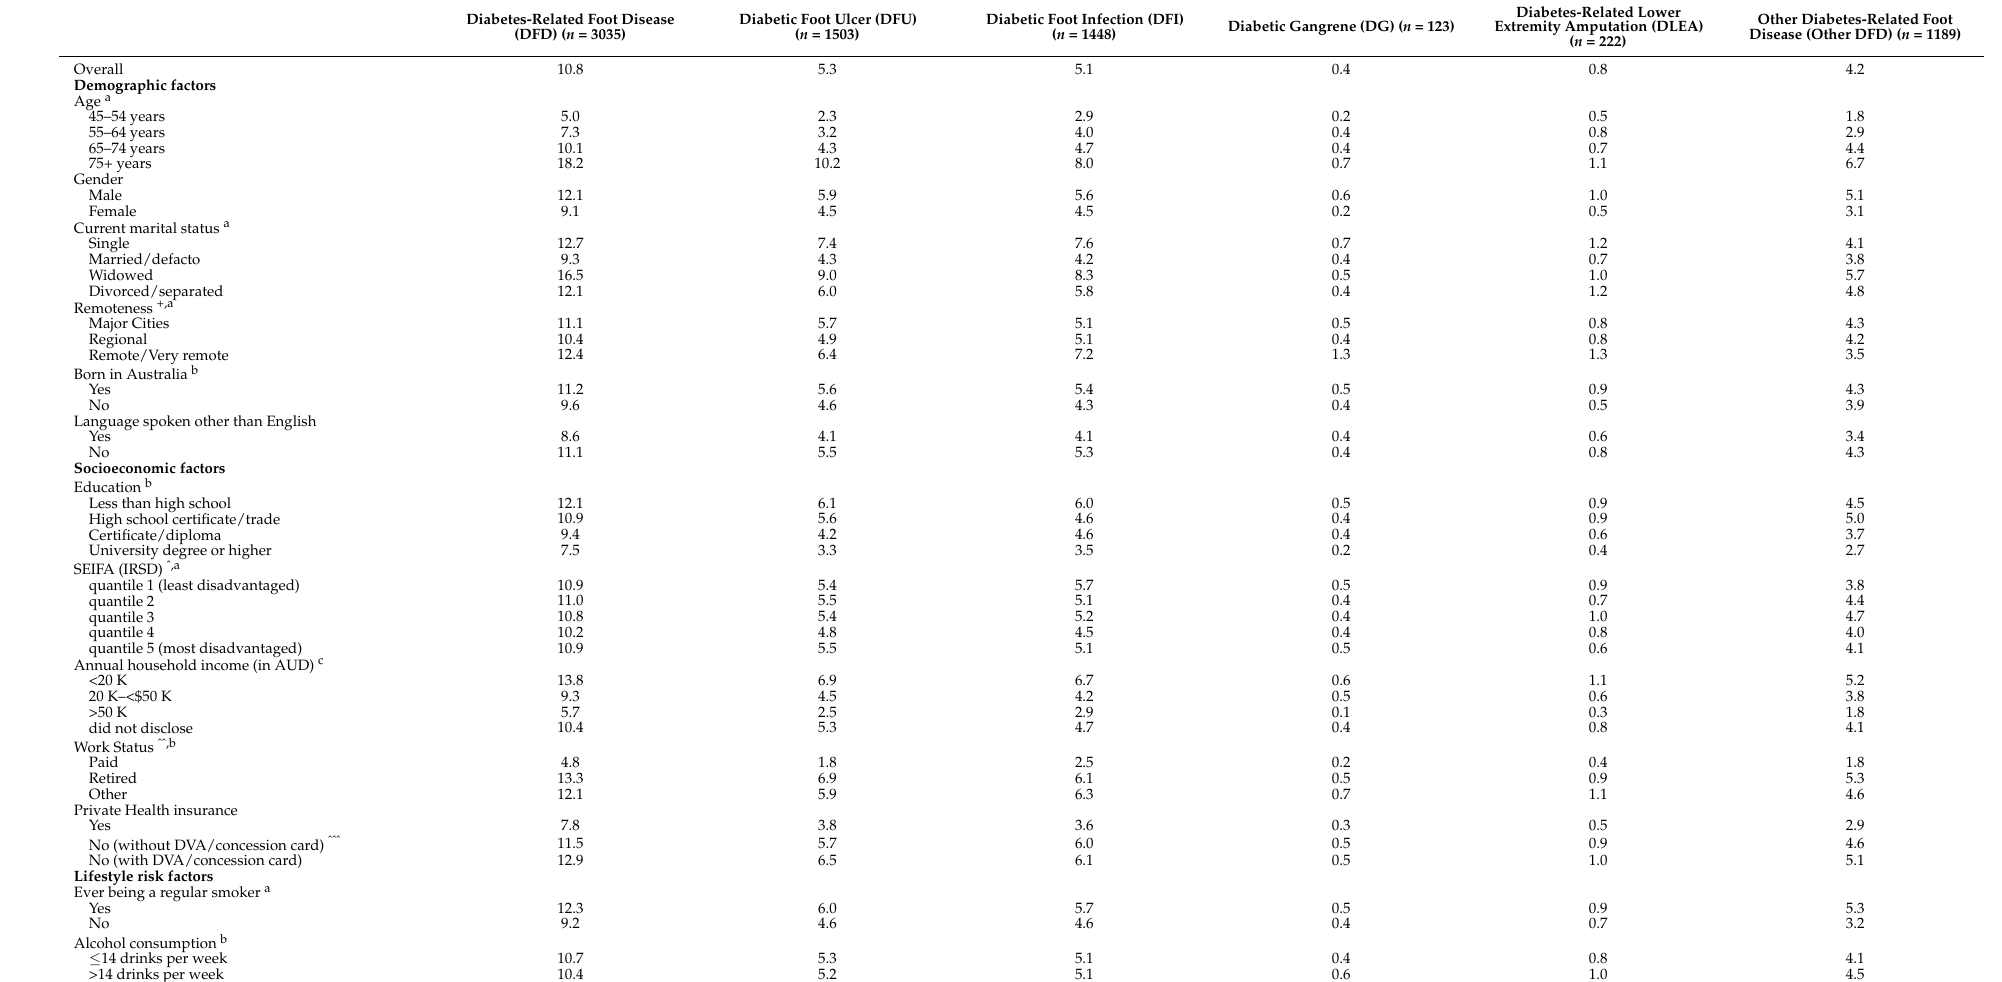
Table A5. Prevalence (unweighted) of DFD, DFU, DFI, DG, DLEA, and other DFD among people with diabetes in terms of demographic, socioeconomic, and lifestyle risk factors.